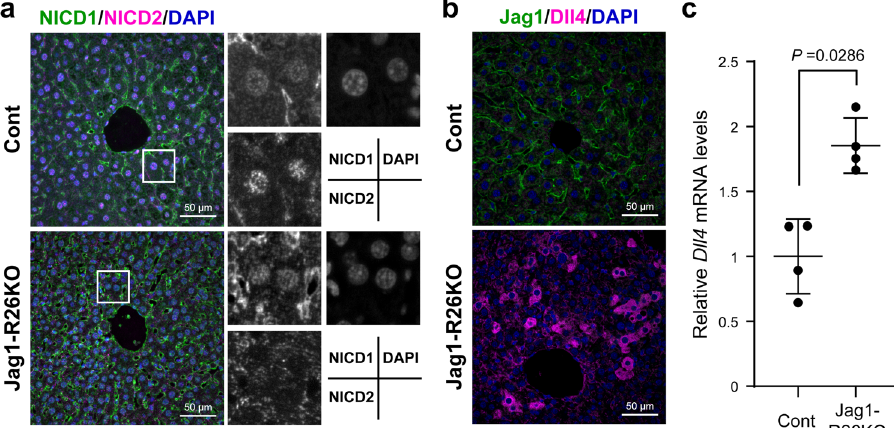
Fig. 5 Ectopic expression of Dll4 in hepatocytes induced by the loss of Jag1/Notch2 signaling. ( a , b ) Immuno fl uorescent co-staining of NICD1 ( green ) and NICD2 ( magenta ) ( a ) or Jag1 ( green ) and Dll4 ( magenta ) ( b ) was performed using the liver tissues from the DEN-treated male control (Cont) and Rosa26 CreER / + / Jag1 loxP / loxP (Jag1-R26KO) mice that were administered tamoxifen at 8 weeks of age. Nuclei were stained with DAPI ( blue ). Scale bar, 50 μ m. c Quantitative RT-PCR analysis of Dll4 gene was performed using liver tissue from male control and Jag1-R26KO mice. The values represent the mean ± SD from four samples in each group and are expressed relative to the mean value in control (set as